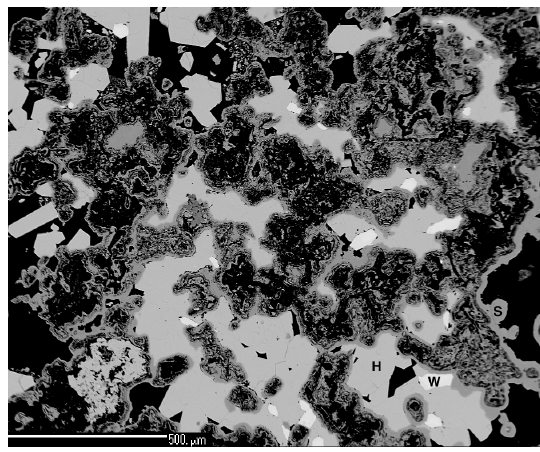
Figure 2. Backscattered scanning electron micrograph showing textural relationships between willemite (bright, W), hemimorphite (intermediate, H) and smithsonite (dark, S) in sample TM06-18. Willemite analysis #40, Table S1 is from this sample.